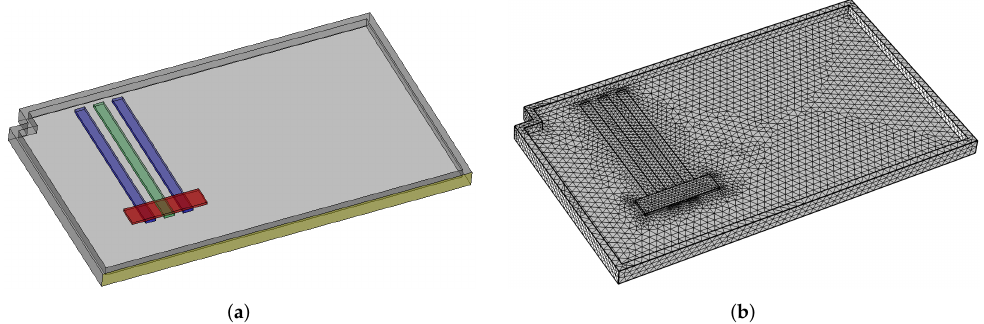
Figure 5. Geometry (in green and blue—the three heat pipes, in red—the heat source) and mesh used for the preliminary CFD simulation ( a ) Geometry. ( b )